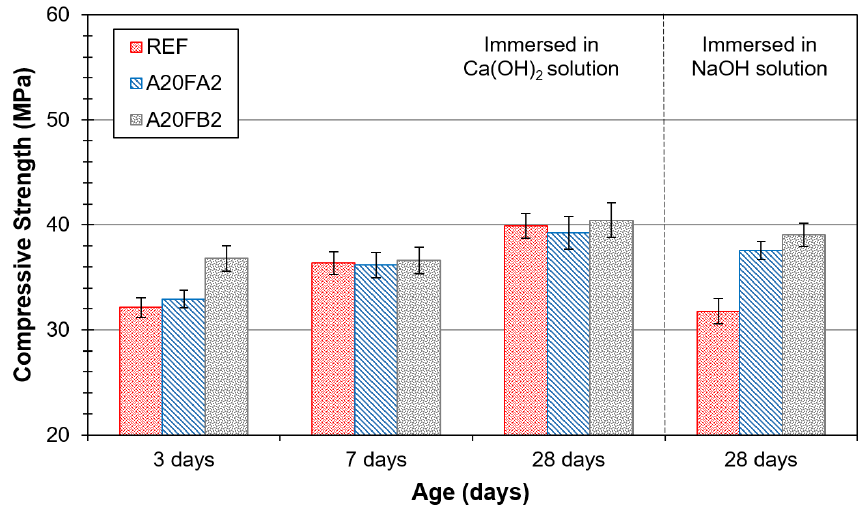
Figure 10. Compressive strength of reference mortars and containing 20% of the GRF, at 3, 7 and 28 days immersed in saturated solution in lime and at 28 days immersed in solution of NaOH 1N.